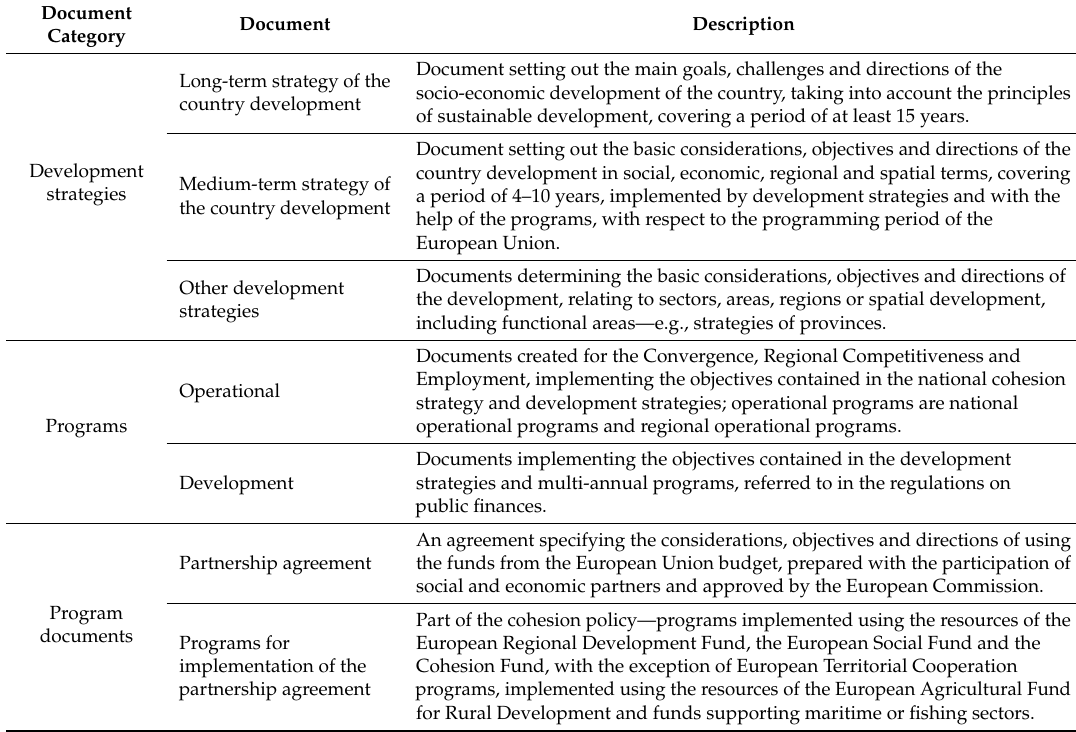
Table 3. Documents created as part of the development policy. Source: own study based on